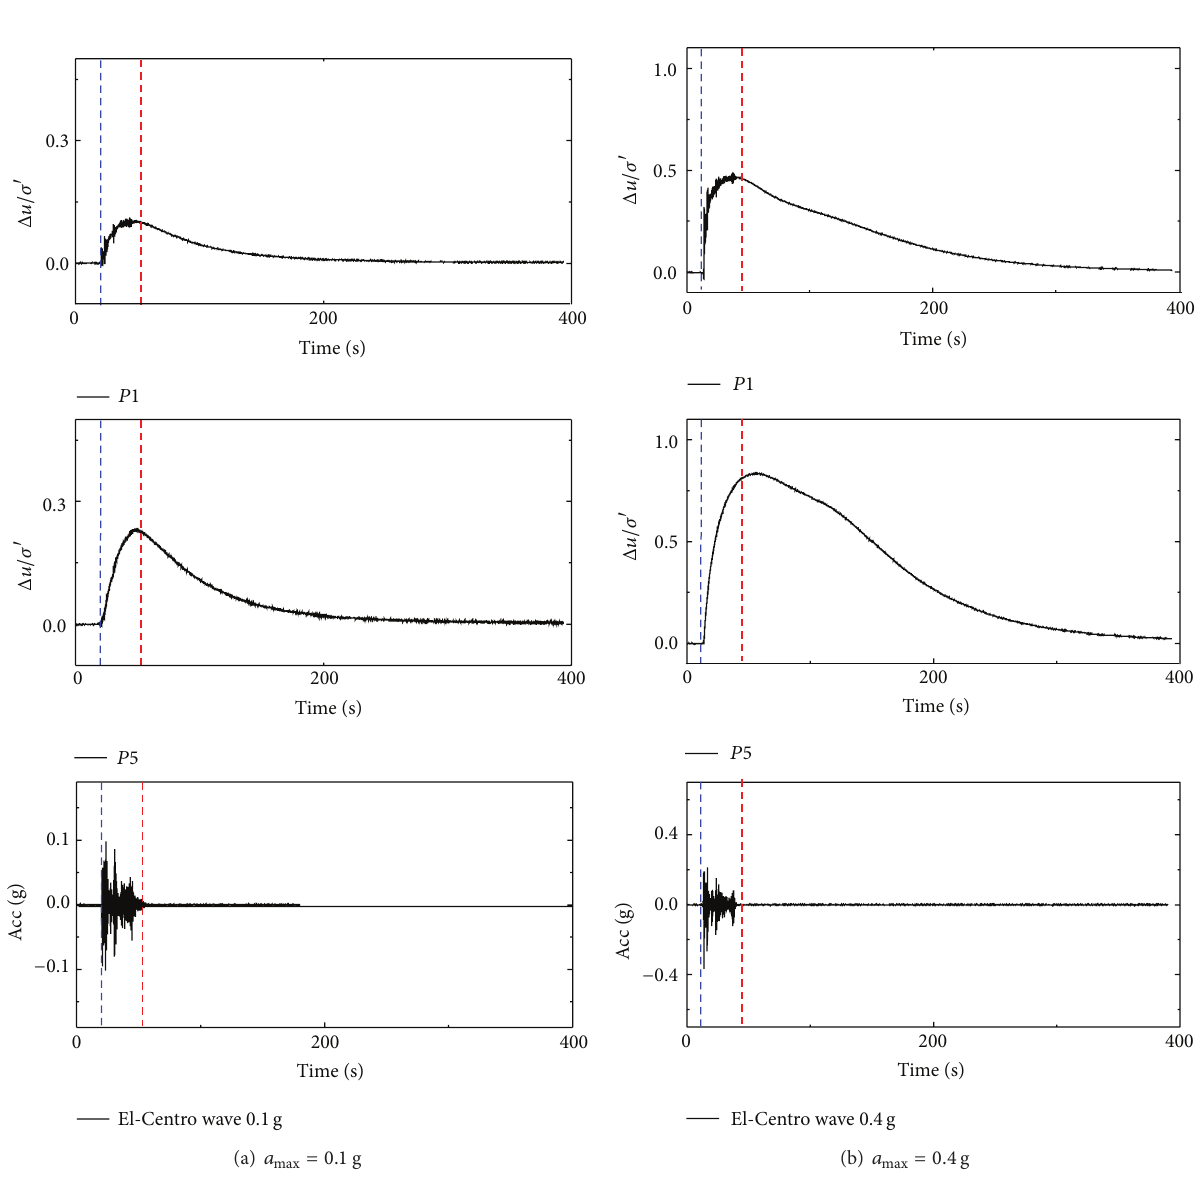
Figure 3: Ground response of Δ𝑢/𝜎 󸀠 in test 2 under El-Centro